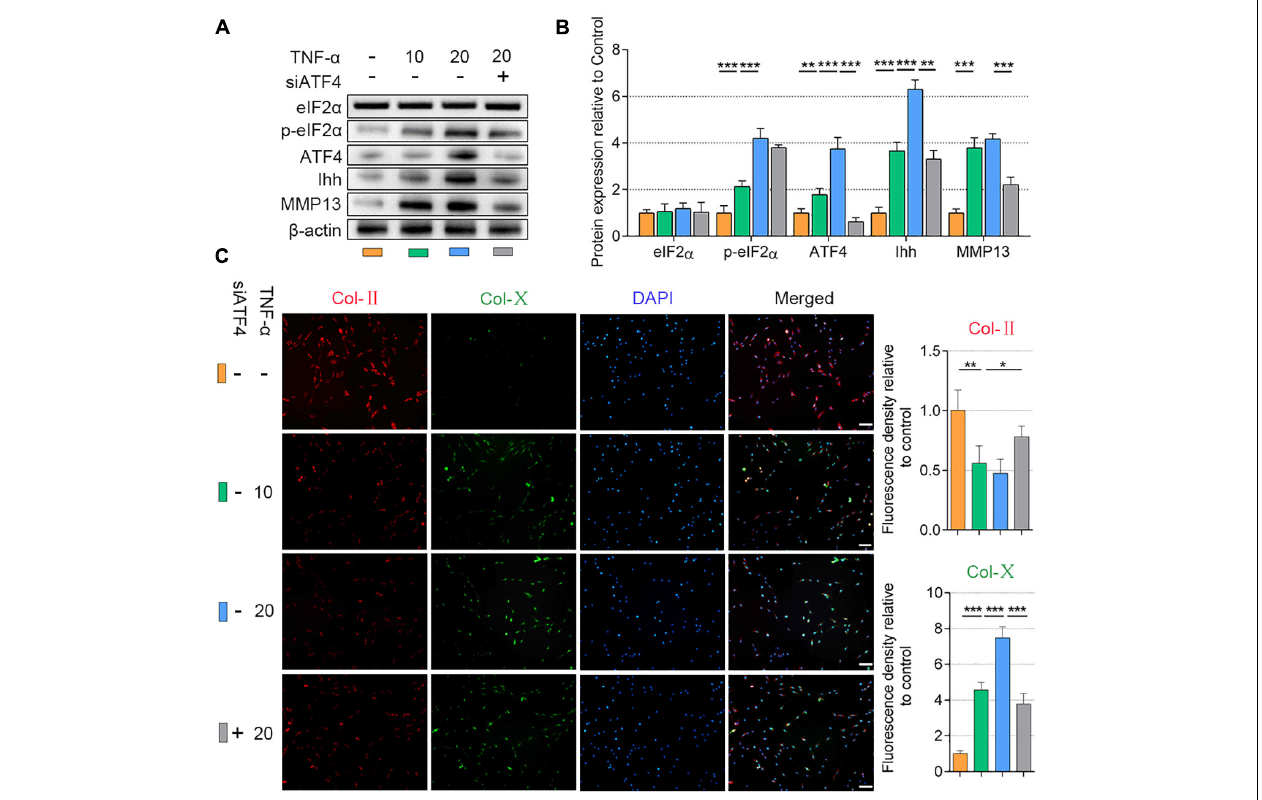
FIGURE 2 | Silencing of ATF4 suppressed Ihh expression and human NP cell degeneration. NP cells were treated with low dose (10 ng/ml) or high dose (20 ng/ml) of TNF- α for 3 days to induce degeneration and transfected with siATF4 to silence the ATF4 gene expression. (A) eIF2 α , p-eIF2 α , ATF4, Ihh, and MMP13 protein levels were assessed by WB, (B) measured by densitometric analyses, and expressed as folds relative to control. (C) Representative images of IF staining with Col-II and Col-X and measured by densitometric analyses and expressed as folds relative to control (scale bar = 100 µ m). Data are presented as means ± SD ( n = 7). * p < 0.05; ** p < 0.01; *** p < 0.001; the orange column indicates control NP cells without any treatments, the green column indicates NP cells treated with 10 ng/ml of TNF- α , the blue column indicates NP cells treated with 20 ng/ml of TNF- α , and the gray column indicates siATF4 transfected NP cells treated with 20 ng/ml of